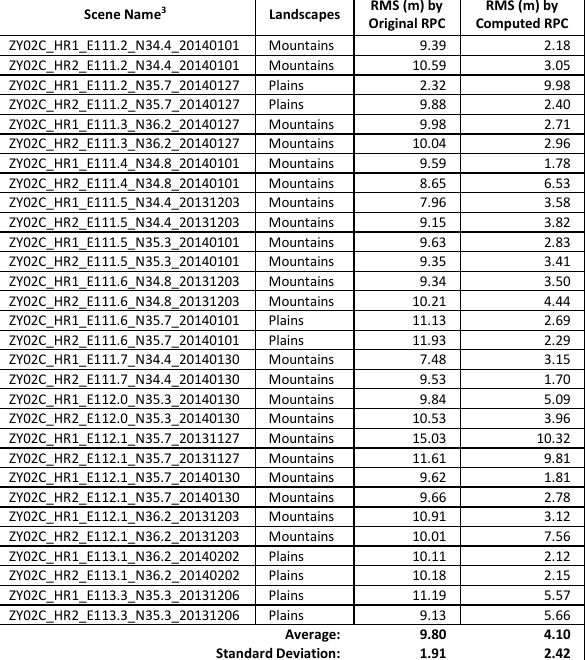
All 31 scenes are then processed using either the simulated Toutin model or the computed RPC and have orthos generated. The 90m SRTM DEM (CGIAR-CSI, 2014) is used in orthorectification. The accuracy of the orthos is measured using nine human-picked points that generally consist of four points around the four image corners, four points in the centers of four image borders, and one in the middle of the entire image. Table 1 lists the residual errors for each image. The residual errors of all scenes in this test distinguish the computed RPC from the simulated Toutin model. It can be seen that the proposed operational correction methodology is much more stable than the simulated Toutin model and achieves about one and half pixels (i.e., 45m on ground) accuracy at average with half pixel standard deviation, while the simulated Toutin model is very unstable because half of its orthos have more than 100 pixels error at average and the rest have about three pixels errors at average.